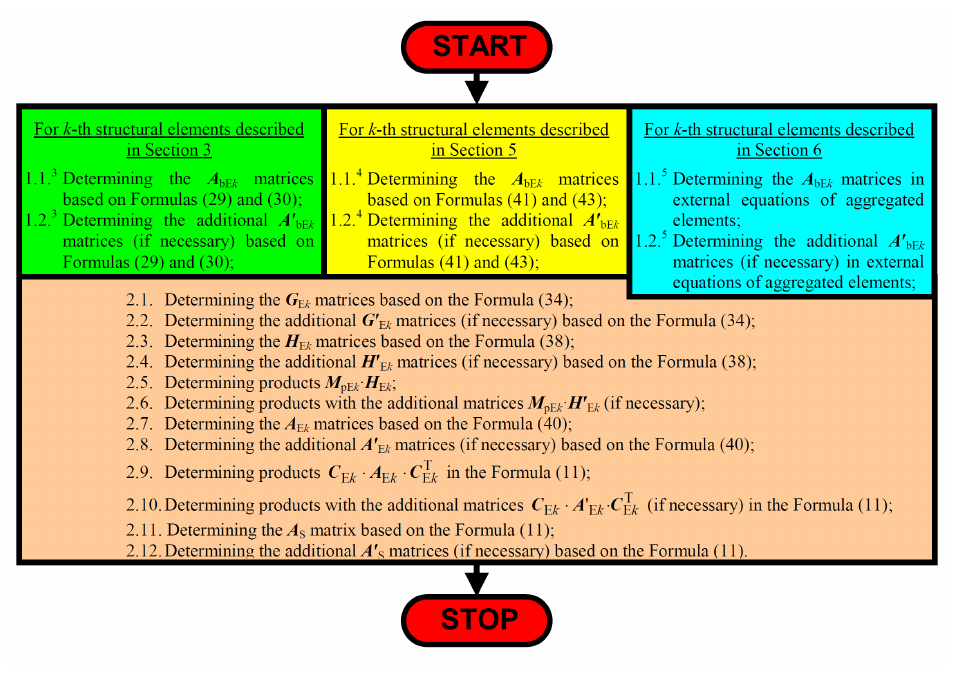
Figure 11. The example algorithm for determining constant matrix and constant expressions for structural elements described in Sections 3, 5 and